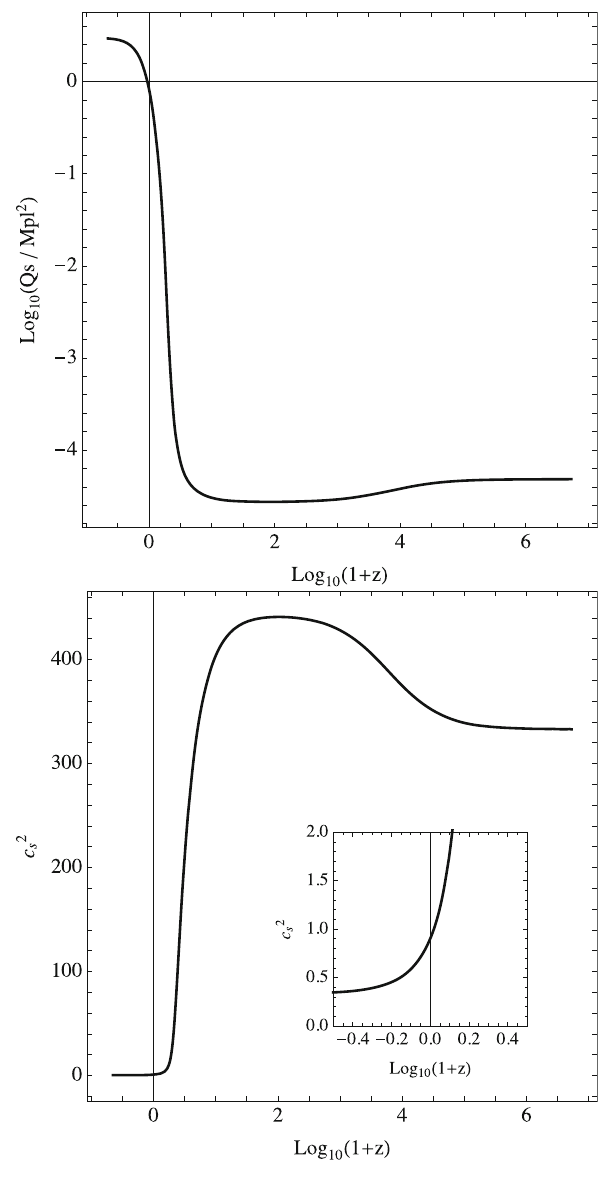
Fig. 3 The evolutions of the Q S as Eq. (5.7) in log scale and the c 2 Eq. (5.8) where the initial conditions are the same as the Fig. 1